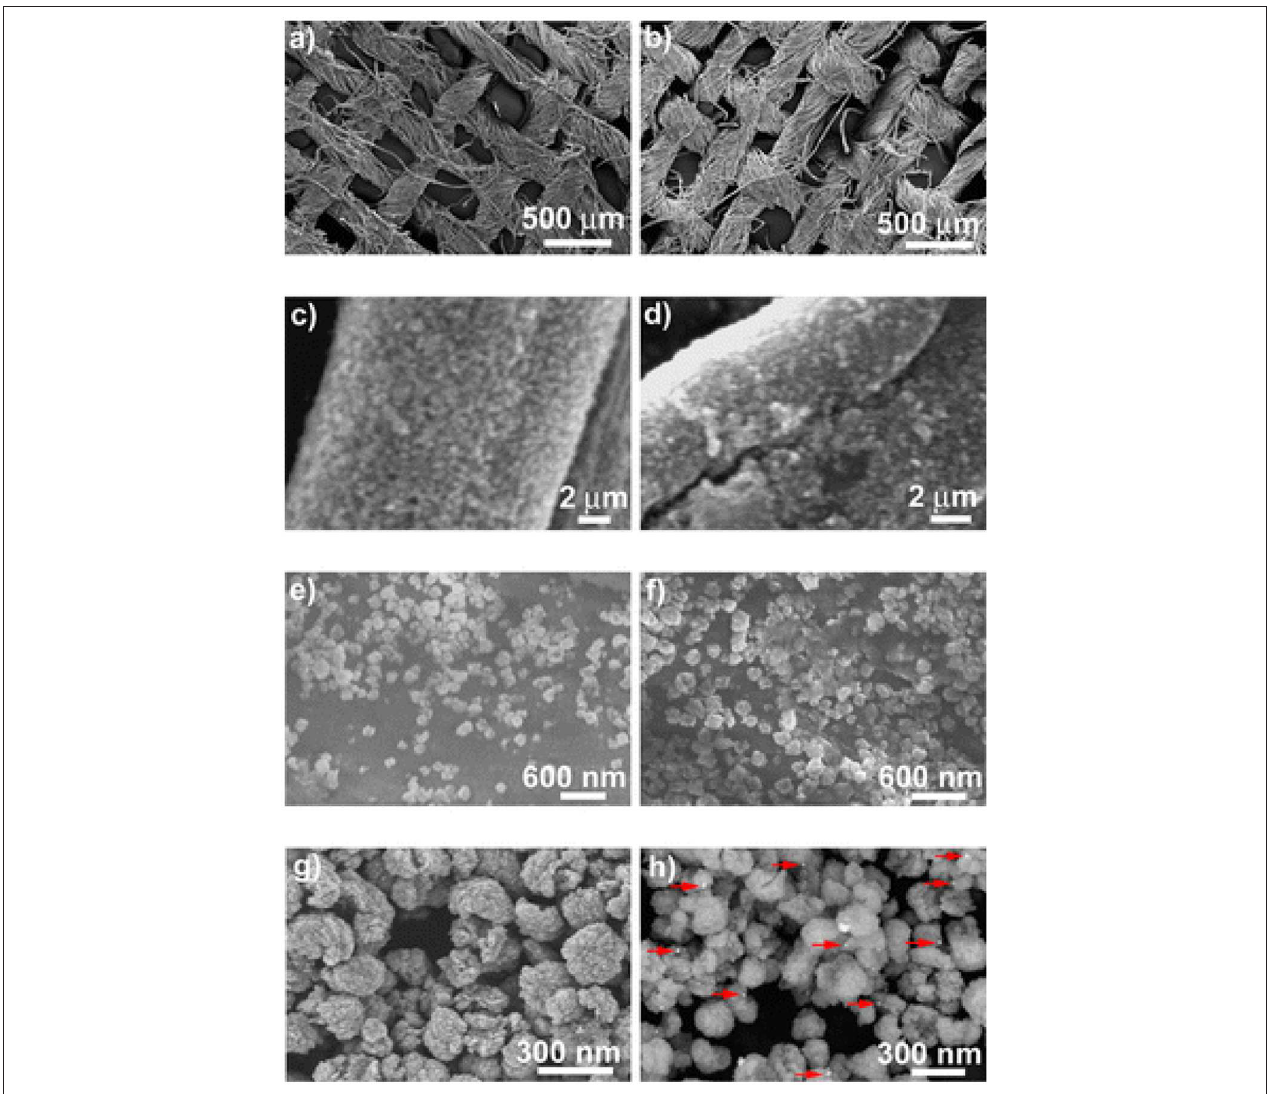
FIGURE 4 | Scanning electron microscopy (SEM) images taken at different magnifications for the cotton fabrics (a,c,e) ZnO@CF and (b,d,f) Ag@ZnO@CF-2.5; field emission SEM (FESEM) images depicting (g) ZnO and (h) Ag@ZnO particles. The red arrows indicate Ag nanoparticles. Reproduced from Manna et al. (2015) with permission from the American Chemical